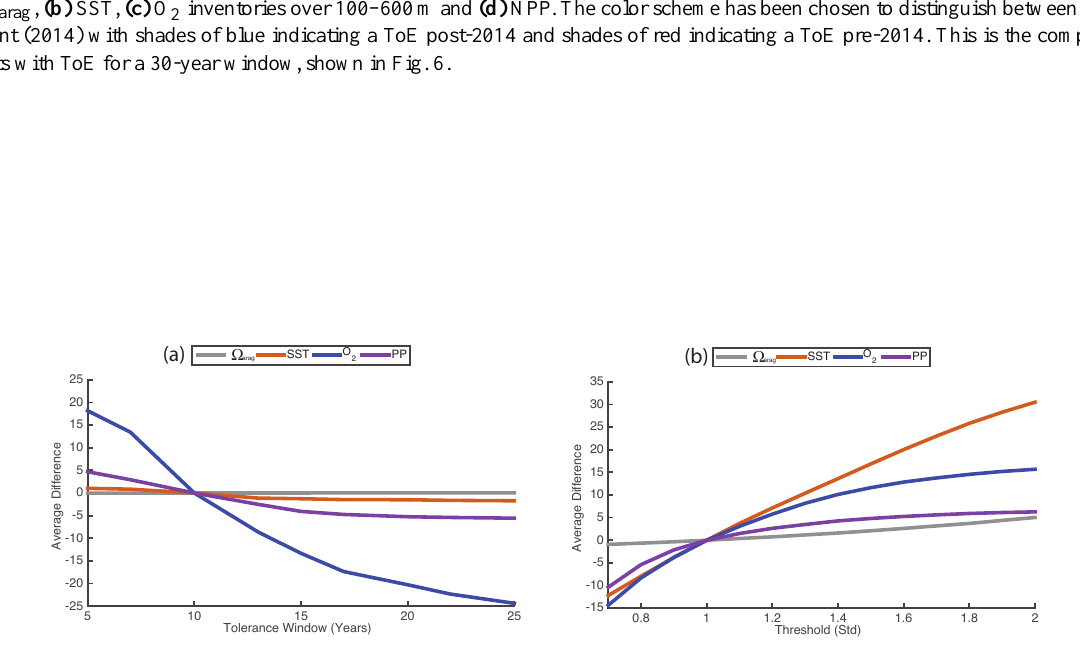
Figure A6. Sensitivity analysis for tolerance window width in years (a) using a 1-standard-deviation threshold and revolved around a 10-year window, as well as threshold level (b) using a 10-year tolerance window and revolved around a standard deviation of 1. Caveats regarding averaging over fields that experience saturation are discussed in the text of the Supplementary